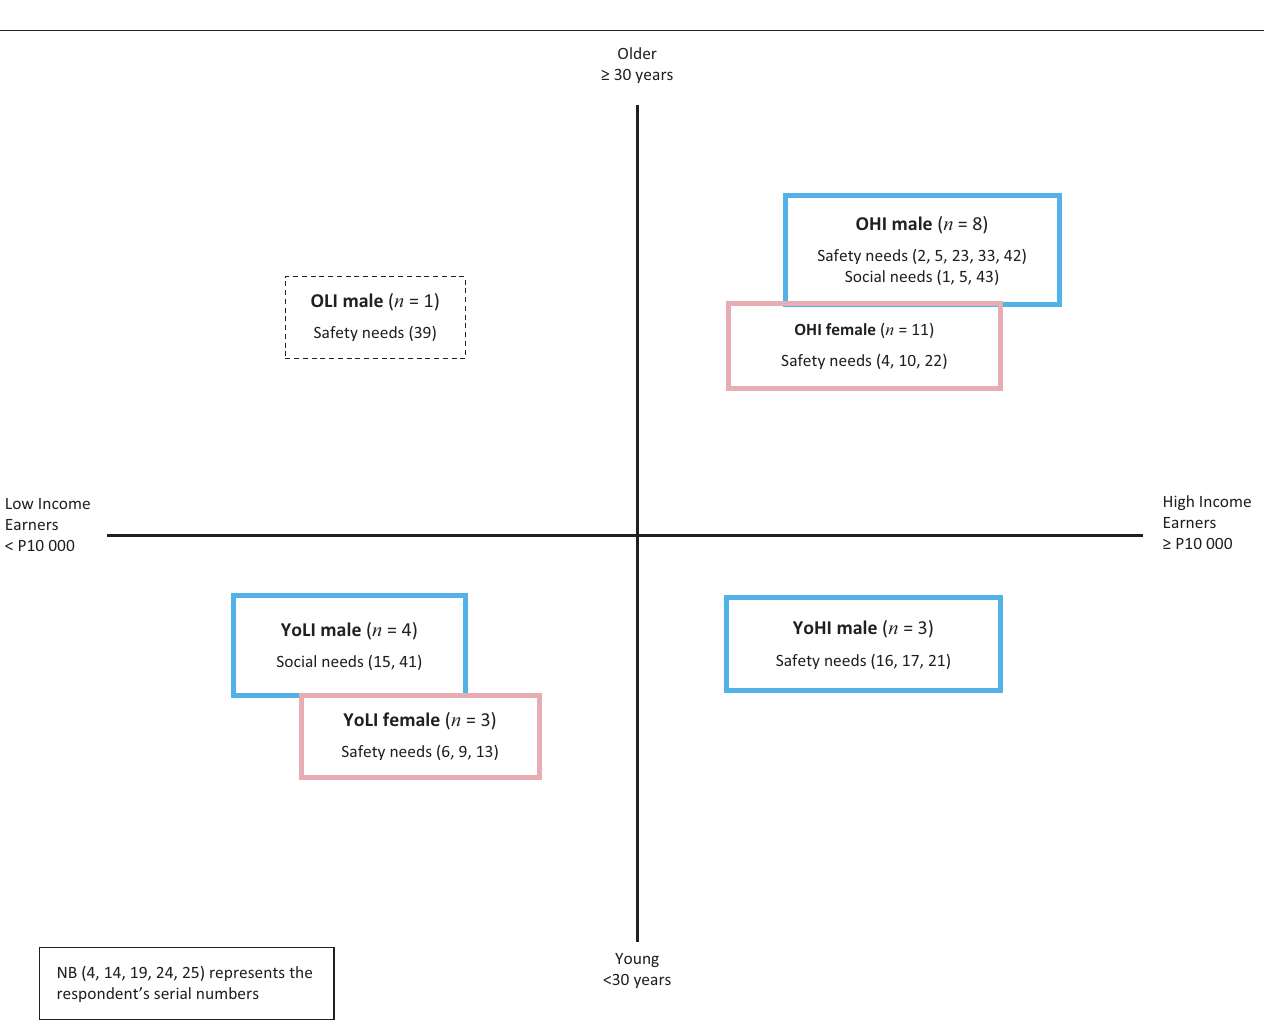
FIGURE 2: Motives for